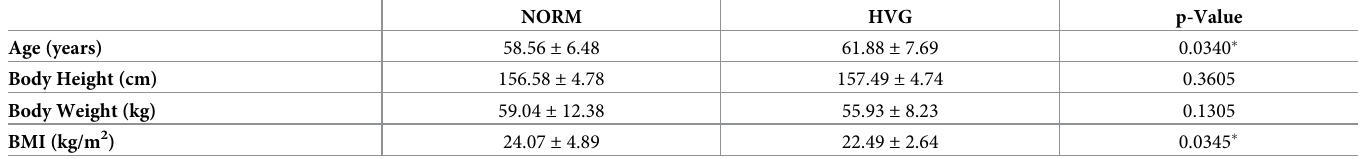
Table 1. Physical characteristics of NORM and HVG groups. The results are represented as mean ± SD, compared using Student’s t-test. P-value was set as 0.05. NORM